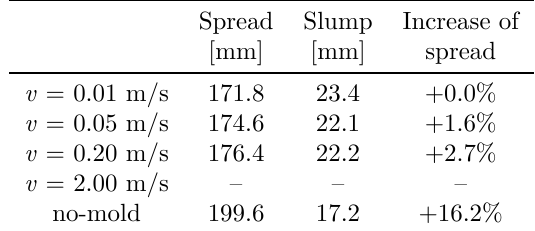
higher than in the previous case with no-slip b.c. but